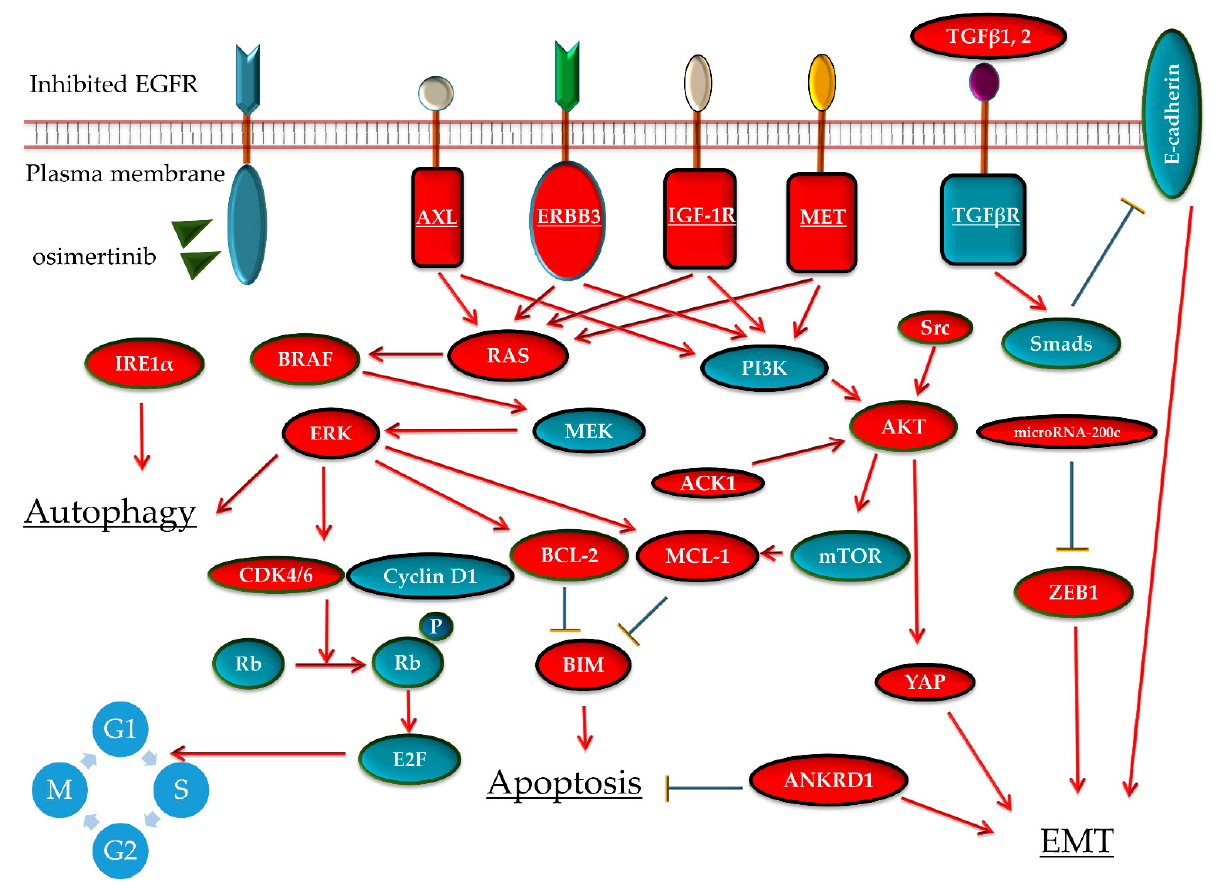
Figure 2. Scheme of the signal pathway and molecules that reportedly cause osimertinib resistance—AXL [39,41,52], HER3 [45], IGF1R [51,57], MET [33,52], TGF β 1 [40], TGF β 2 [59], BRAF [43], RAS [32,35], ERK [37], Src-AKT [35], ACK1 [48], CDK4/6 [55], BCL-2 [56], MCL-1 [34], BIM [34,50], YAP [54], ANKRD1 [36], microRNA-200c [46], ZEB1 [46,58], and IRE1 α [38] (highlighted in red)—in cell line models treated with osimertinib. EGFR, epidermal growth factor receptor; AXL, AXL receptor tyrosine kinase; ERBB3, human epidermal growth factor receptor-3; IGF1R, insulin-like growth factor-1 receptor; MET, MET proto-oncogene, receptor tyrosine kinase; TGF, transforming growth factor; ACK1, activated Cdc42- associated kinase-1; CDK4/6, cyclin-dependent kinase; BCL-2, B-cell lymphoma-2; YAP, yes-associated protein; ANKRD1, ankyrin repeat domain-1; IRE1 α , inositol-requiring enzyme-1 α